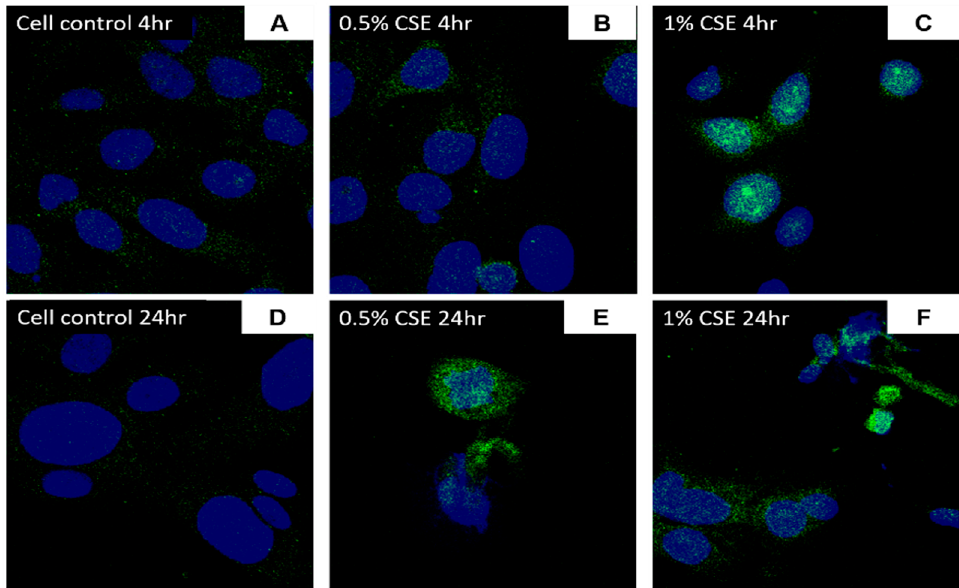
Figure 9. ACE2 protein expression in BEAS-2B cells following cigarette smoke exposure: BEAS-2B cells were exposed to cigarette smoke extract (CSE, 0.5% and 1%) for 4 or 24 h. Protein expression of ACE2 was assessed through immunofluorescence staining for 4 h ( B , C ) and 24 h ( E , F ) treatments in comparison with cell controls ( A , D ). Images at 40×.